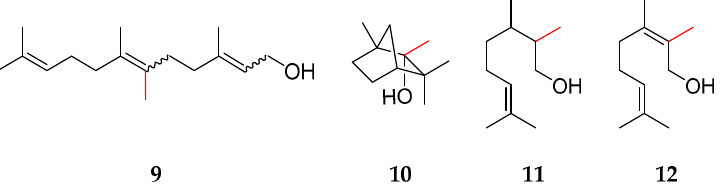
Figure 2. Structures of methylated terpenes described by Kschowak et al. with red-labeled bonds added to the additional methyl group: 6-methylfarnesol 9 , 2-methyl-α-fenchol 10 , 2-methylcitronellol 11 , and 2-methylnerol 12 .